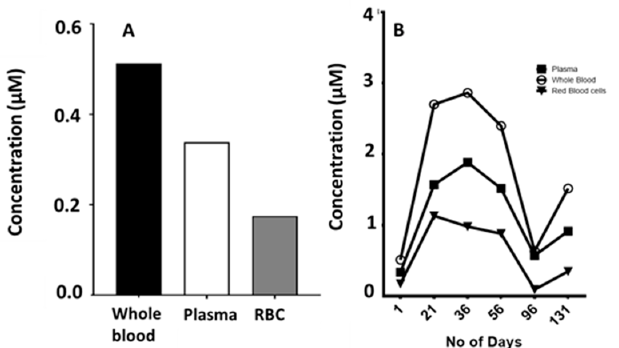
Figure 9. Crizotinib disposition in the blood components following standard dosing (250 mg twice daily) of a single NSCLC patient at the start (day 1) of treatment ( A ). Blood compartment disposition in time after 1, 2, 3, and 6 months of crizotinib treatment ( B ).